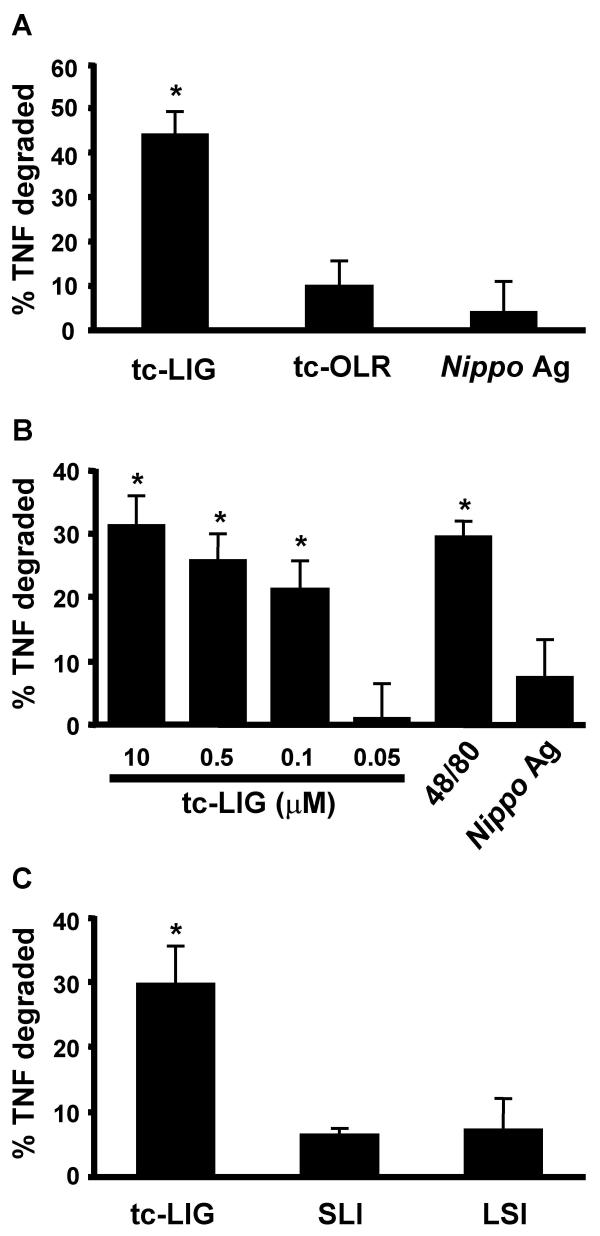
PAR-2ap, PAR-2cp compound 48/80 and Ag-mediated release of proteolytic activity from mast cells. (A) Supernatants from PMC treated with tc-LIG (10 μM), tc-OLR (10 μM), or Ag (10 We/mL) for 8 hr were incubated with 150 pg/mL of TNF. Proteolytic activity was calculated as % degraded TNF according to the formula given in Methods section. Values in the graph indicate proteolytic activity after the subtraction of activity released by sham-treated cells (17 ± 7 %). (B) TNF-degrading proteolytic activity released from PMC by various doses of tc-LIG (20 min). Values in the graph indicate proteolytic activity after the subtraction of activity released by sham-treated cells (22 ± 5 %). (C) TNF-degrading proteolytic activity released by SLI (PAR2-ap, 40 μM), LSI (PAR2-cp, 40 μM) and tc-LIG (10 μM) treated PMC (20 min). Values in the graph indicate proteolytic activity after the subtraction of activity released by sham-treated cells (23 ± 7 %). Values are shown as "mean ± SEM" (n = 3–5). Star indicates statistically significant difference from spontaneous (p < 0.05).